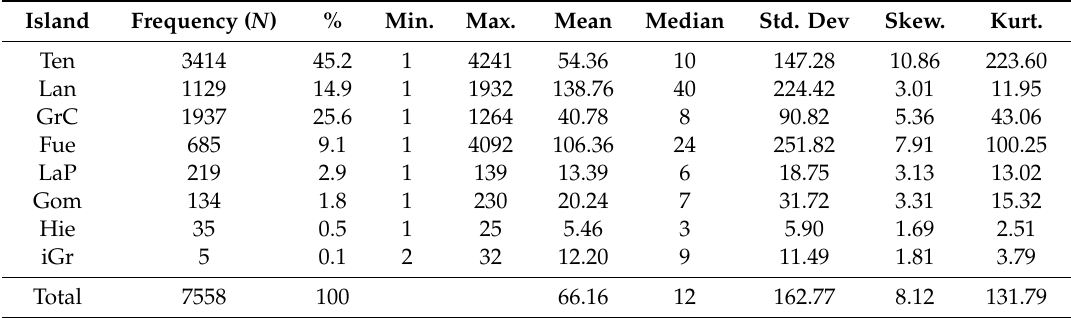
Table 5. Number of restaurants per island ( N and %); and reviews between 2013 and 2017. Island Frequency ( N ) % Min. Max. Mean Median Std. Dev Skew. Kurt. Ten 3414 45.2